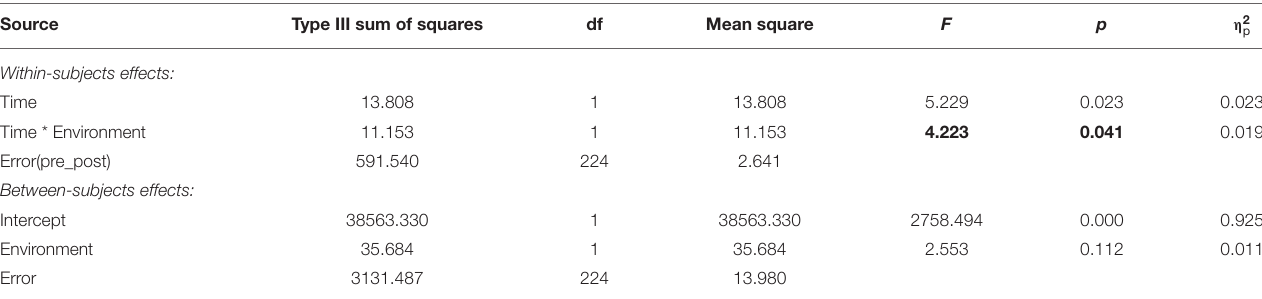
TABLE 8 | Results from ANOVAs on time (pre, post) × environment (nature, urban) effects on BDS, for studies with environment as a between-subjects